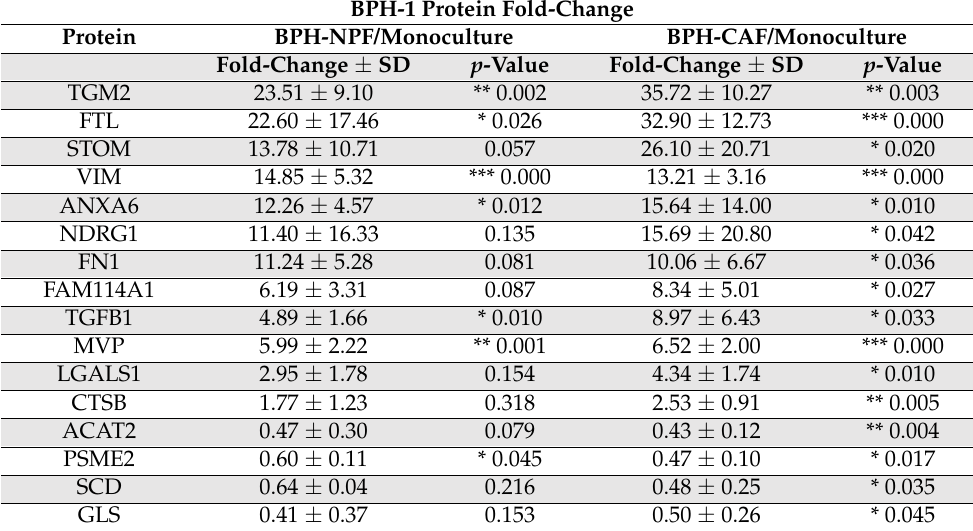
Table 1. BPH-1 Protein fold-change in co-culture experiments. Top differentially regulated proteins in BPH-1 cells in CAF co-culture compared to monoculture (>twofold change in either direction and p < 0.05) compared to BPH1 in NPF co-culture vs. monoculture. Data are displayed as mean fold- change of raw protein intensity from mass spectrometry measurement ± SD from three biological replicates and p - value calculated from Student’s t -test comparing monoculture and co-culture. * p < 0.05, ** p < 0.01, *** p < 0.001